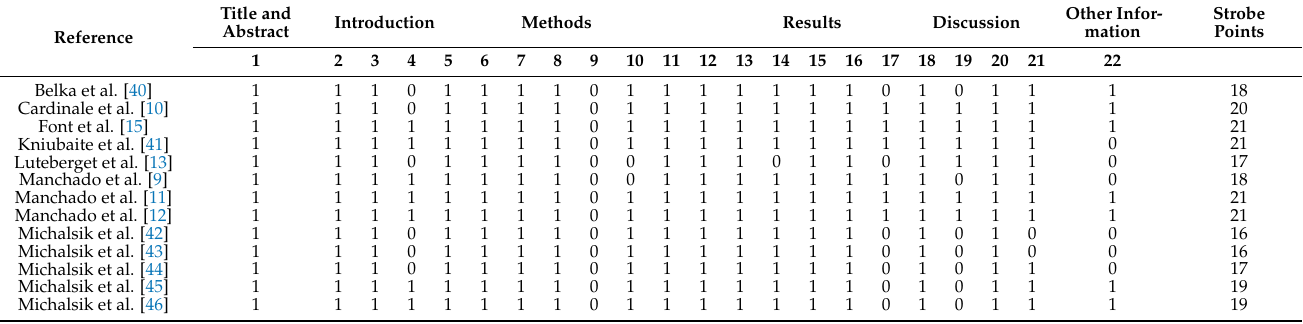
Table 5. The study quality analysis (‘STROBE’